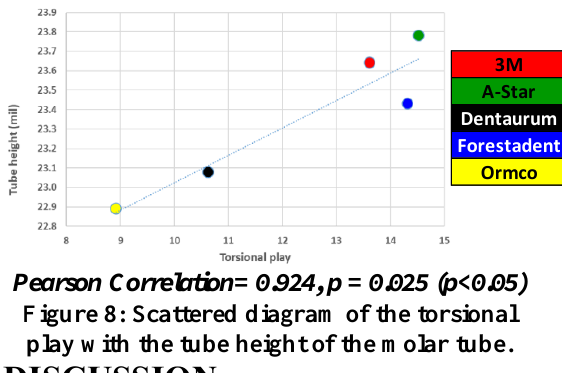
Figure 8: Scattered diagram of the torsional play with the tube height of the molar